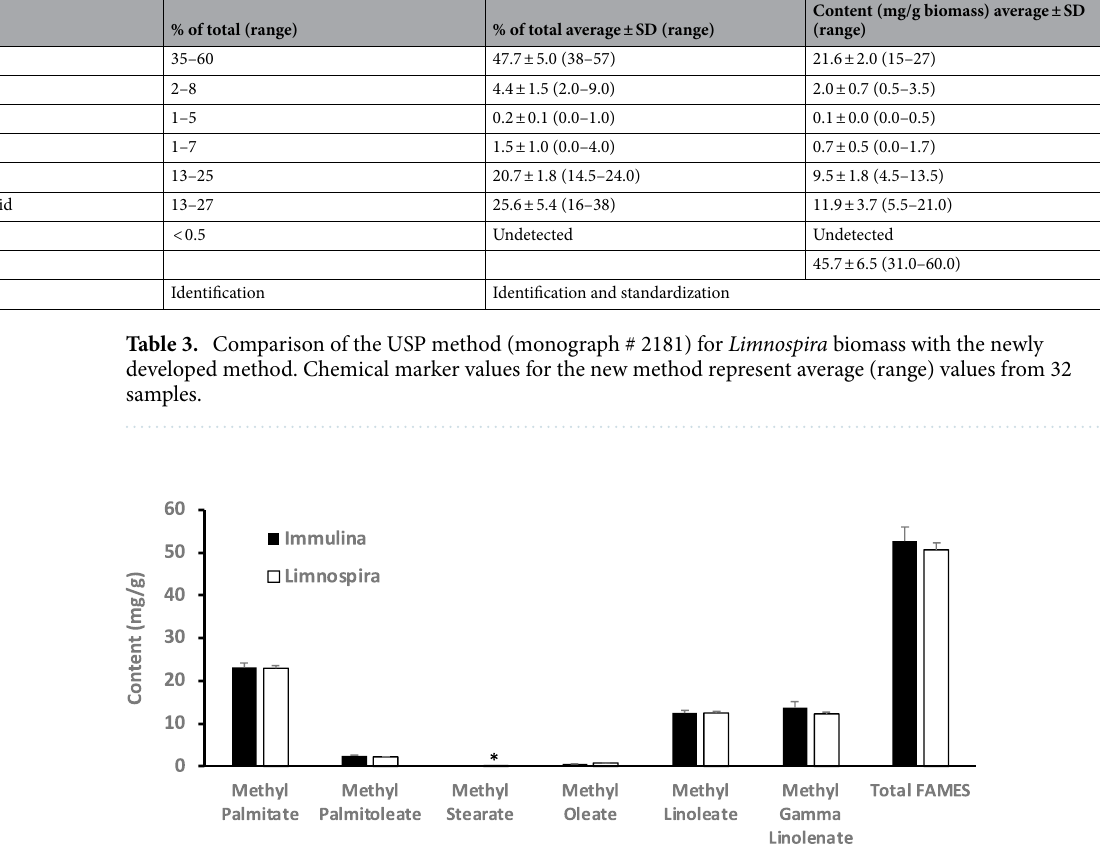
Table S1 online). The selective ions, m/z 69 for methyl oleate; m/z 74 for palmitate, palmitoleate, and stearate methyl esters; m/z 79 for α-linolenate and γ-linolenate methyl esters; and m/z 81 for linoleate methyl ester were